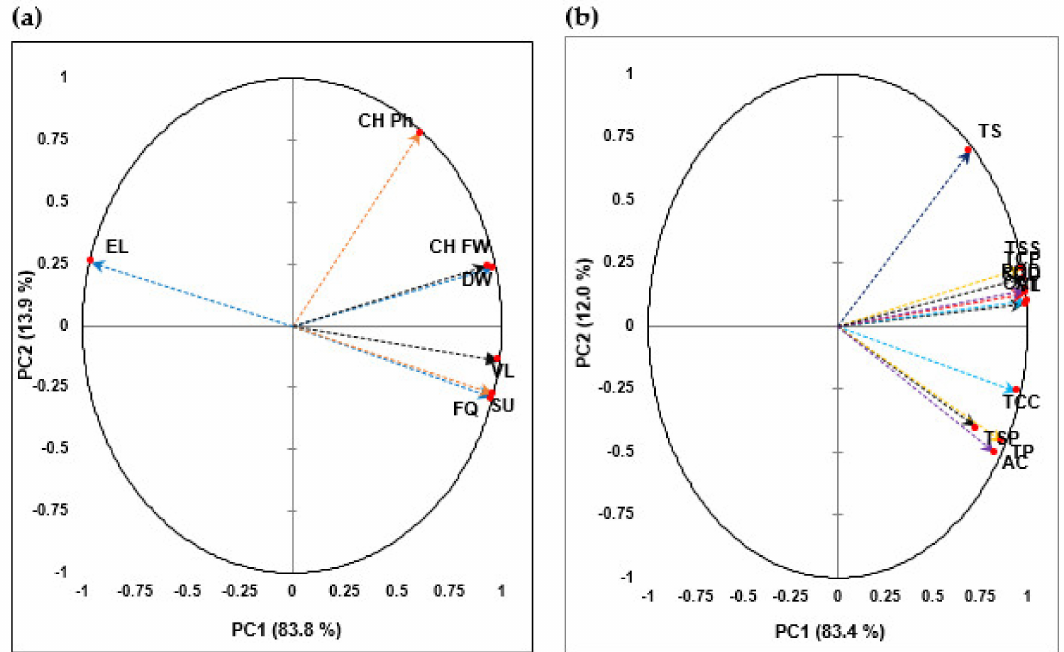
Figure 1. Principal component analysis of ( a ) the vase life and physiological parameters and ( b ) vase life and biochemical parameters: ( a ) (vase life (VL), change in fresh weight (CH FW), dry weight (DW), flower quality (FQ), and solution uptake (SU) and ( b ) total sugar (TS), total chlorophyll content (TCC), total soluble protein (TSP), total phenolic (TP), peroxidase (POD), catalase (CAT), and superoxide dismutase (SOD). PC1 and PC2 mean principal component 1 and